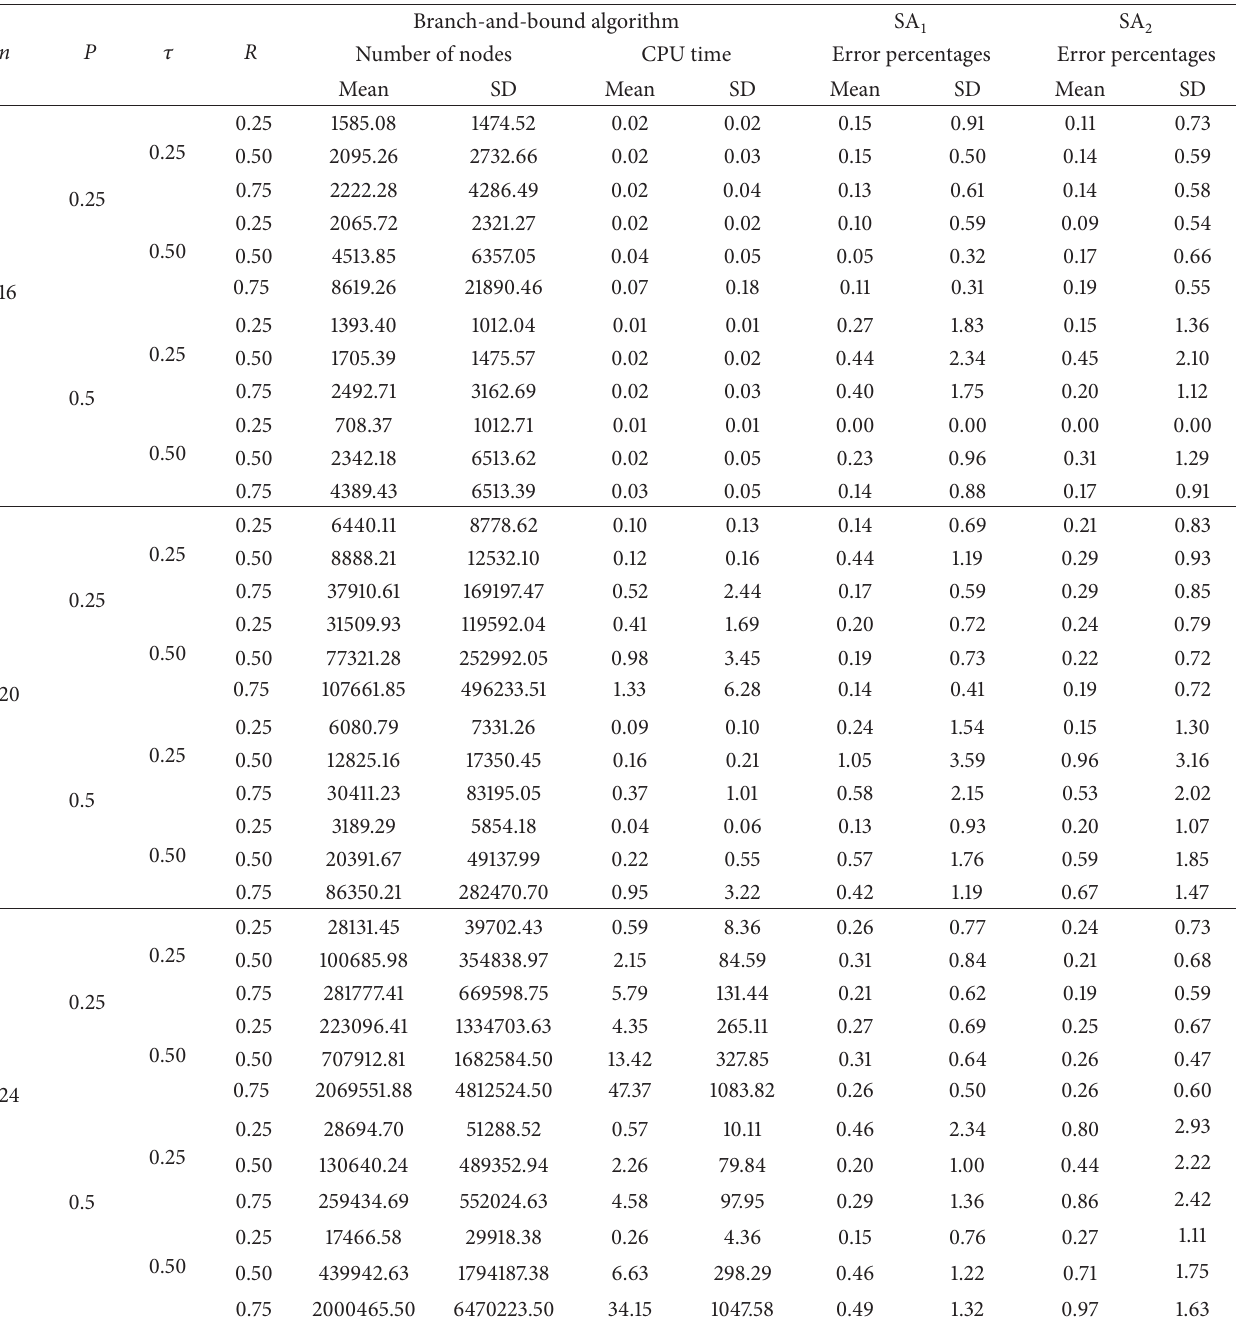
Table 5: The performance of the B&B and SA algorithms ( 𝜃 = 0.5